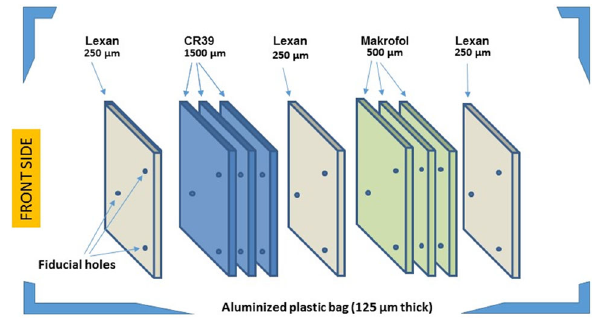
Fig. 6 NTD module composition